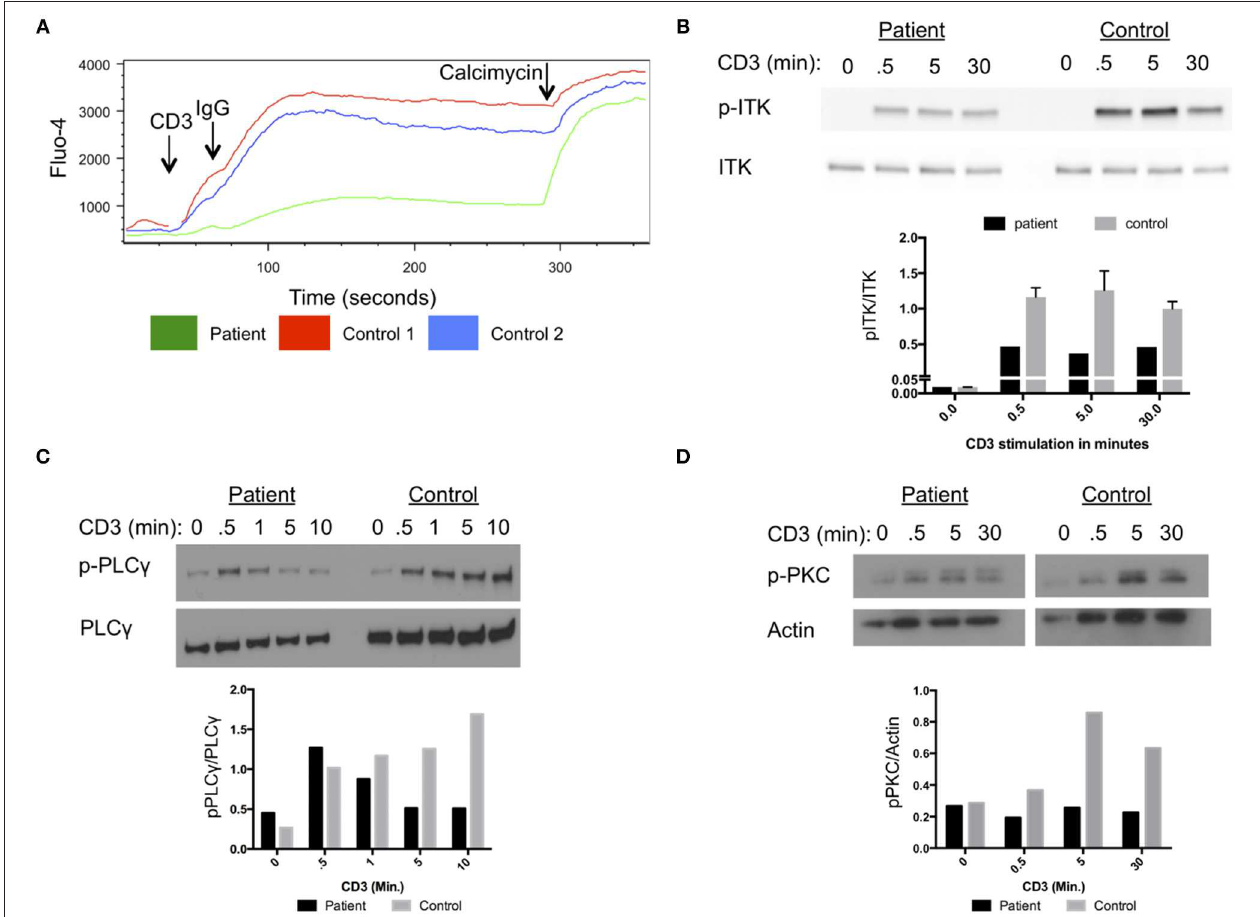
FIGURE 2 | Impaired T cell receptor signaling in cells from the patient with homozygous ITK mutations. (A) Impaired calcium flux in the patient compared to healthy controls following anti-CD3 crosslinking, plotted by Fluo-4 as a function of time. (B) Impaired phosphorylation of ITK in patient cells following stimulation for the indicated times with anti-CD3 antibody, compared to control cells. (C) Phosphorylation of PLC γ at various times after CD3 stimulation in patient and control. Total PLC γ served as a loading control. (D) Phosphorylation of PKC in patient cells following CD3 stimulation at various times compared to control. Actin served as a loading control. (B–D) The graphs show quantification of the blots. The experiments were repeated three times and a representative result is